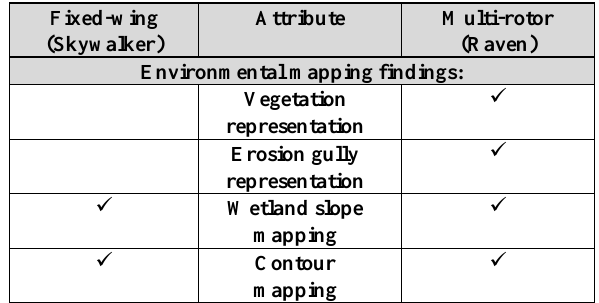
Table 7. Comparison of study